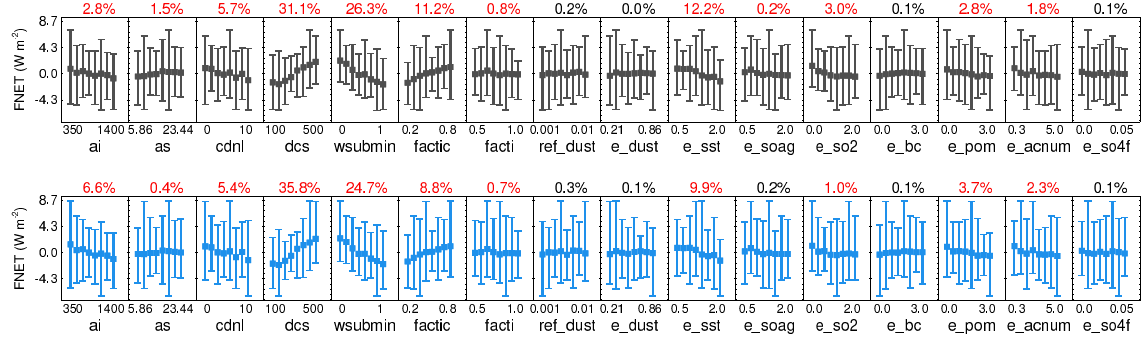
Fig. 11. As in Fig. 10 but showing parametric sensitivities of the global mean (a) shortwave and (b) longwave cloud forcing (unit: Wm − 2 ).